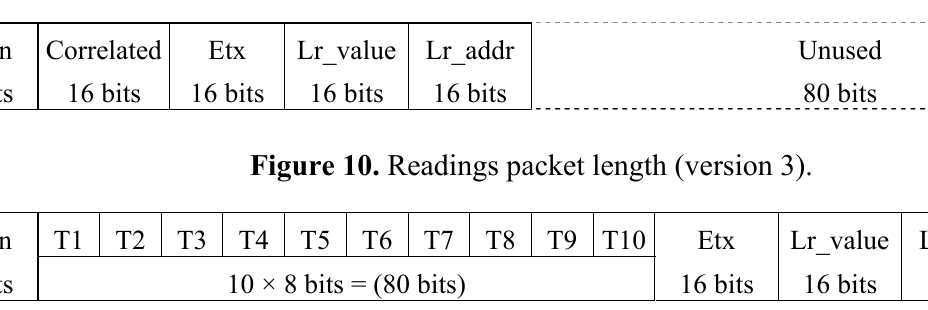
Figure 9. Correlation packet length (version 3).